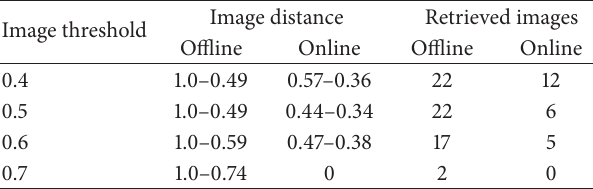
Table 2: Comparison between the online and offline